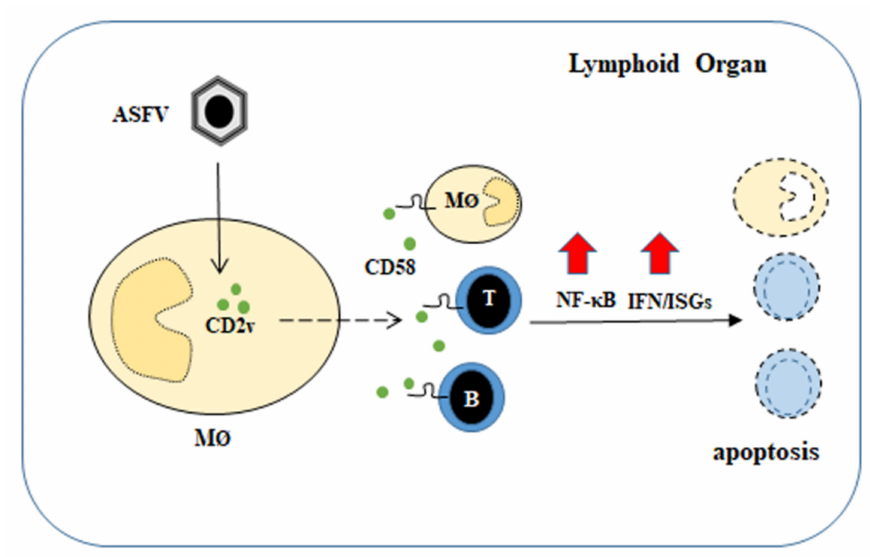
Figure 9. Proposed mechanism of action of ASFV CD2v. CD2v present on infected cell membranes and/or released from ASFV-infected macrophages interacts with surrounding lymphocytes and macrophages via CD58. This interaction promotes NF- κ B activation and induction of IFN- β and ISGs, which lead to the apoptosis of lymphocytes and macrophages. A dashed arrow indicates that the mechanism responsible for CD2v presence in the supernatant is yet to be determined.